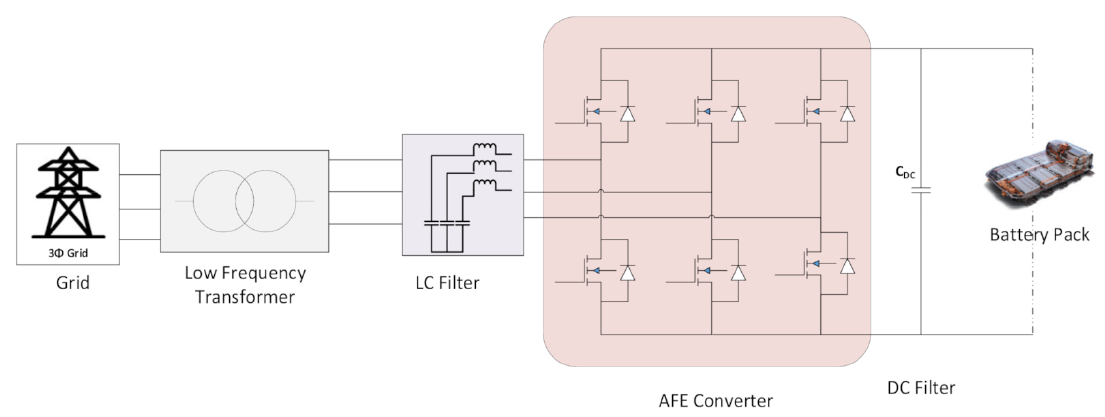
Figure 2. Off-board charger topology.